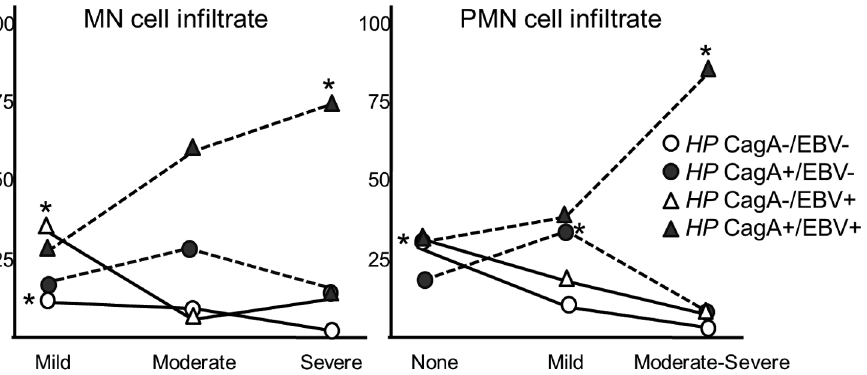
Figure 2. Infection frequencies and gastritis severity related to the presence of CagA. Asterisks denote associations with statistical significance: HP CagA 2 /EBV 2 and HP CagA 2 /EBV + groups with mild MN and no PMN (open circle and triangle), HP CagA + /EBV 2 (grey circle) with mild PMN, and HP CagA + /EBV + (grey triangle) with severe MN and moderate-severe PMN.